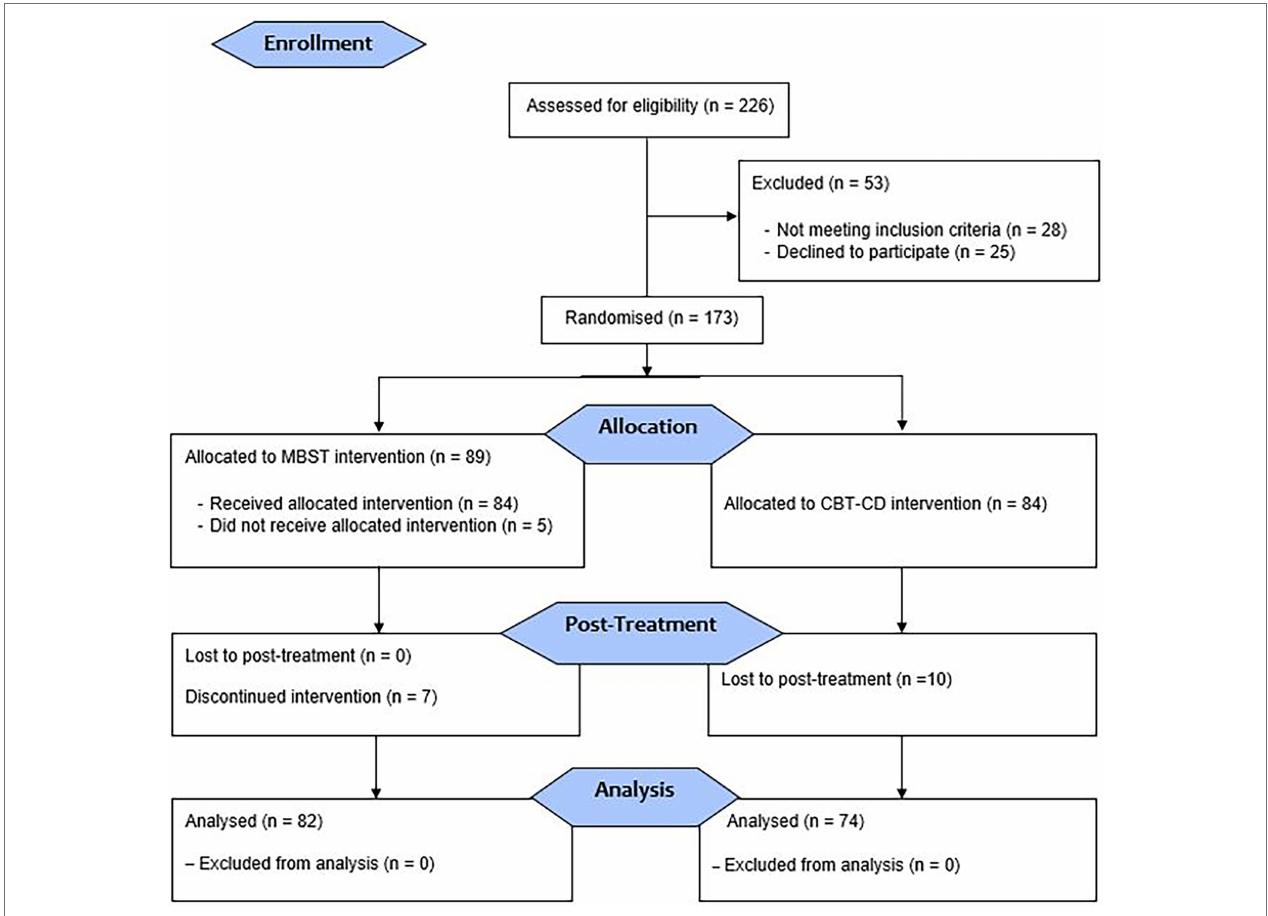
FIGURE 1 | Flow diagram showing the participants’ selection, allocation and